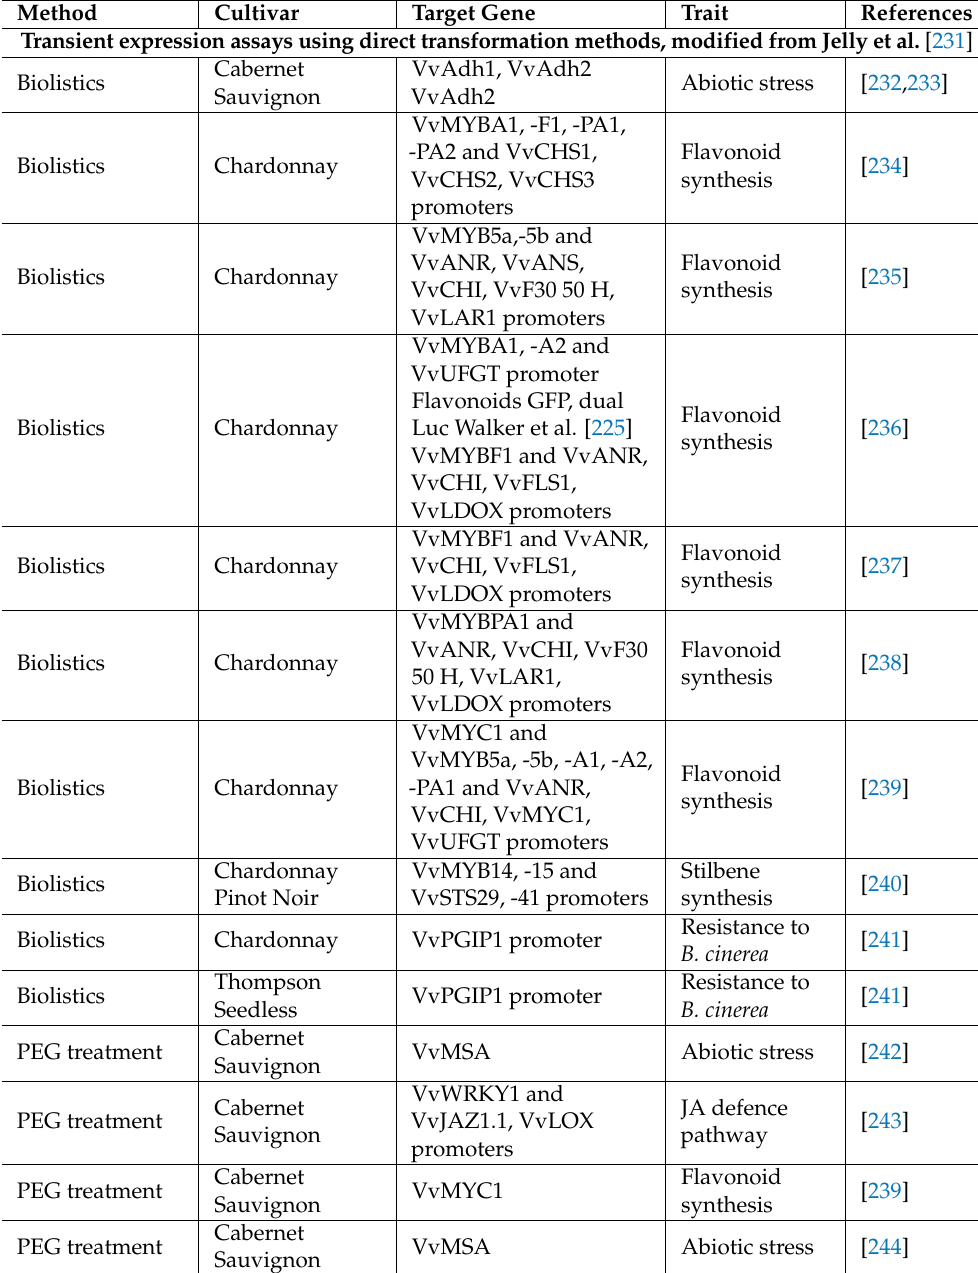
Table 2. Grapevine improvements with genetic